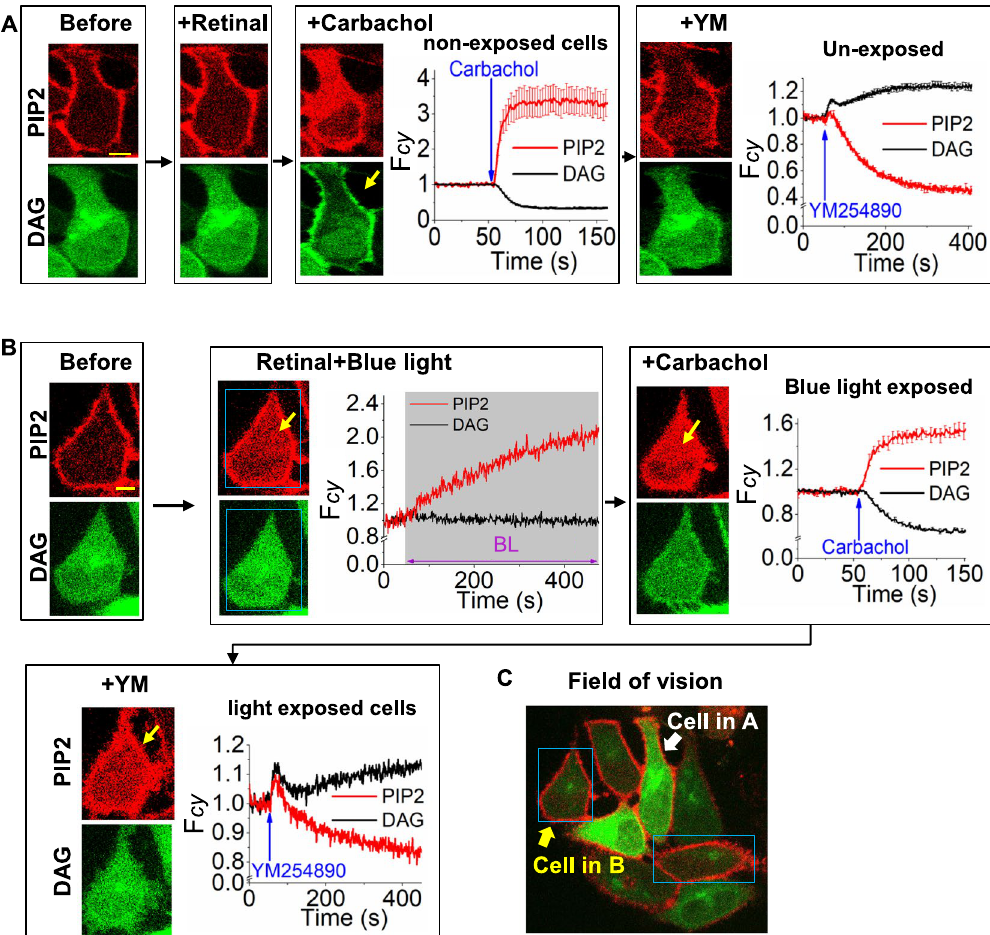
Figure 2. Comparison of M3-muscarnic receptor mediated PIP2 hydrolysis vs blue light excited retinal (BLE-retinal) induced PIP2 sensor translocation. Images of HeLa cells expressing M3-muscarinic receptor, mCherry-PH (PIP2 sensor), DBD-YFP (DAG sensor). ( A ) Without blue light exposure, retinal addition does not change PIP2 or DAG sensor distribution (left), while the addition of carbachol resulted in PIP2 hydrolysis and DAG formation (middle). The addition of Gq inhibitor, YM254890 (1 µ M) to cells resulted in reverse translocation of PIP2 and DAG sensors. (mean ± S.E.M., n = 6 cells) ( B ) When cells were exposed to blue light (4.86 µ W of 445 nm) in the presence of retinal, they only showed PIP2 sensor translocation while no change in DAG sensor was observed (left). The addition of carbachol to these cells exhibited an additional PIP2 sensor translocation to the cytosol with a mild DAG sensor translocation to the PM (left) (mean ± S.E.M., n = 4 cells). Interestingly, addition of YM254890 only reversed both PIP2 and DBD responses elicited by carbachol. ( C ) The field of vision of cells shown in A and B. Mean and S.E.M. are from 3 < independent experiments. (blue light (BL) = blue box). Scale = 5 µ